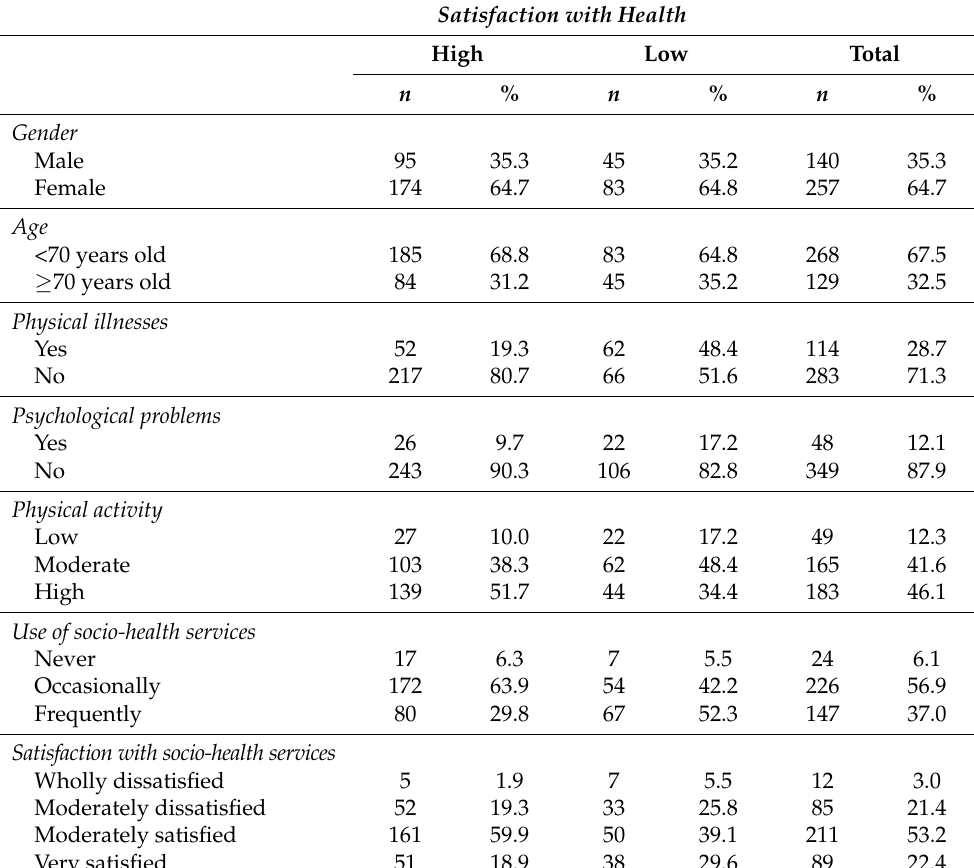
Table 2. Frequencies of genders, age, physical illnesses, psychological problems, PA level and use and satisfaction of socio-health services according to the subjective health of the participants. Satisfaction with Health High